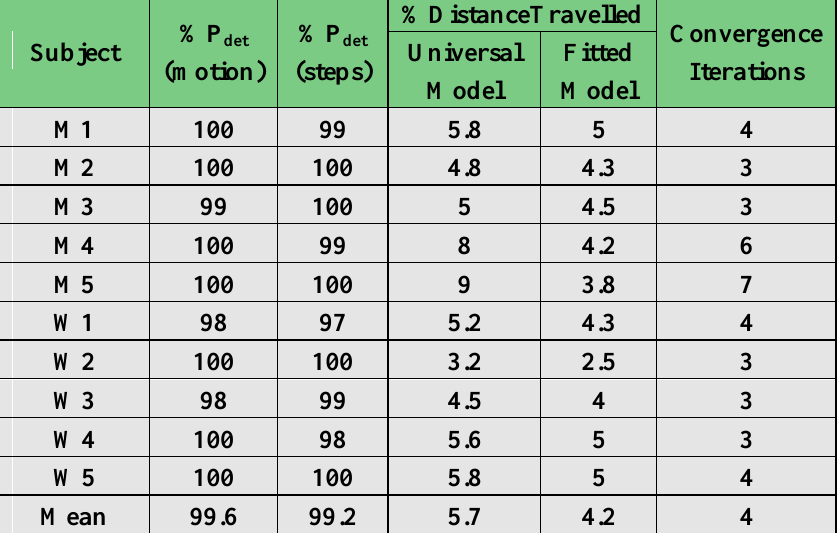
Table 2. Metrics for Evaluating the Handheld Based Step Length